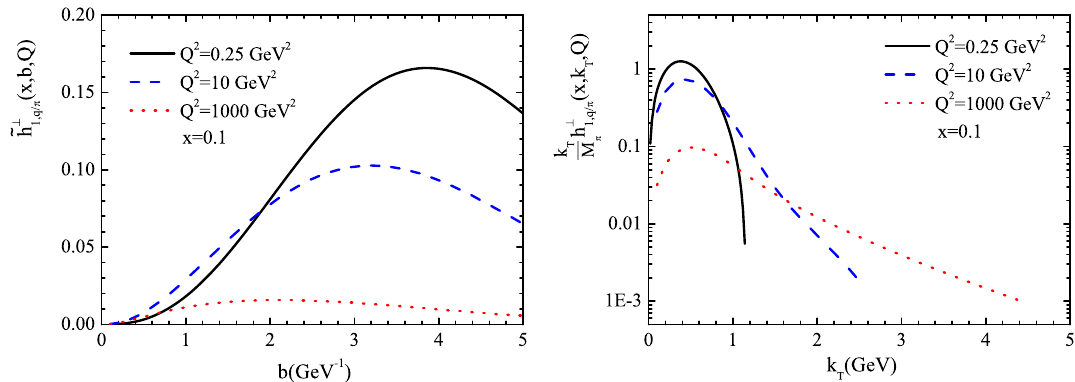
Fig. 1 The Boer-Mulders function for u -quark in b space (left panel) and k T space (right panel) considering three different energy scales: Q 2 = 0 . 25 GeV 2 (solid lines), Q 2 = 10 GeV 2 (dashed lines), Q 2 = 1000 GeV 2 (dotted